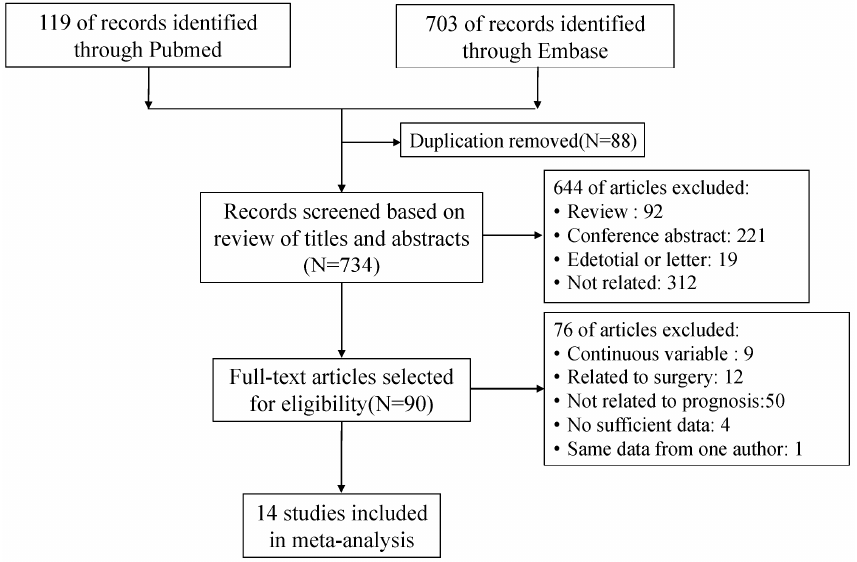
Figure 1. Flow chart of the literature search.